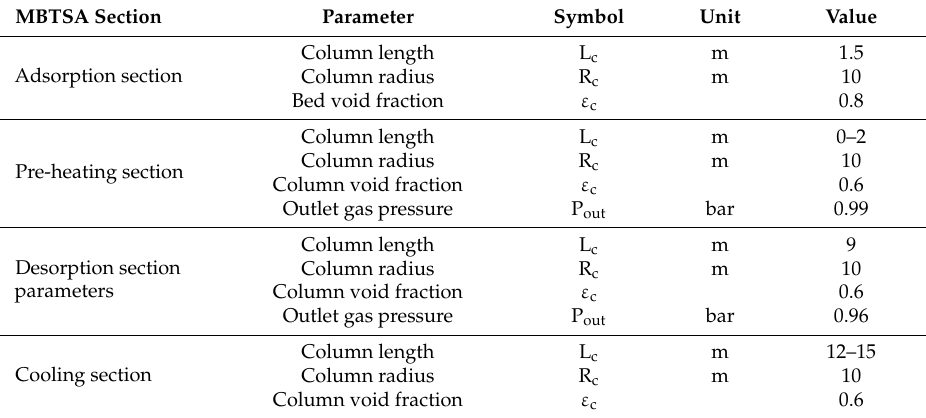
Table 4. Design parameters used in MBTSA